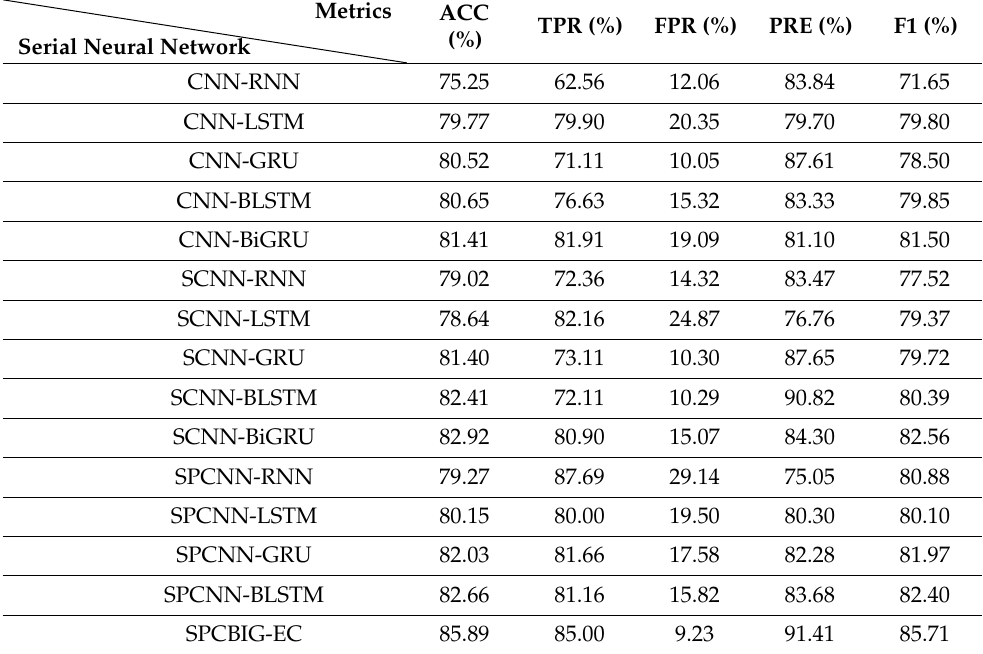
Table 5. The results of the detection of hybrid vulnerabilities with the SCR Detection Framework.